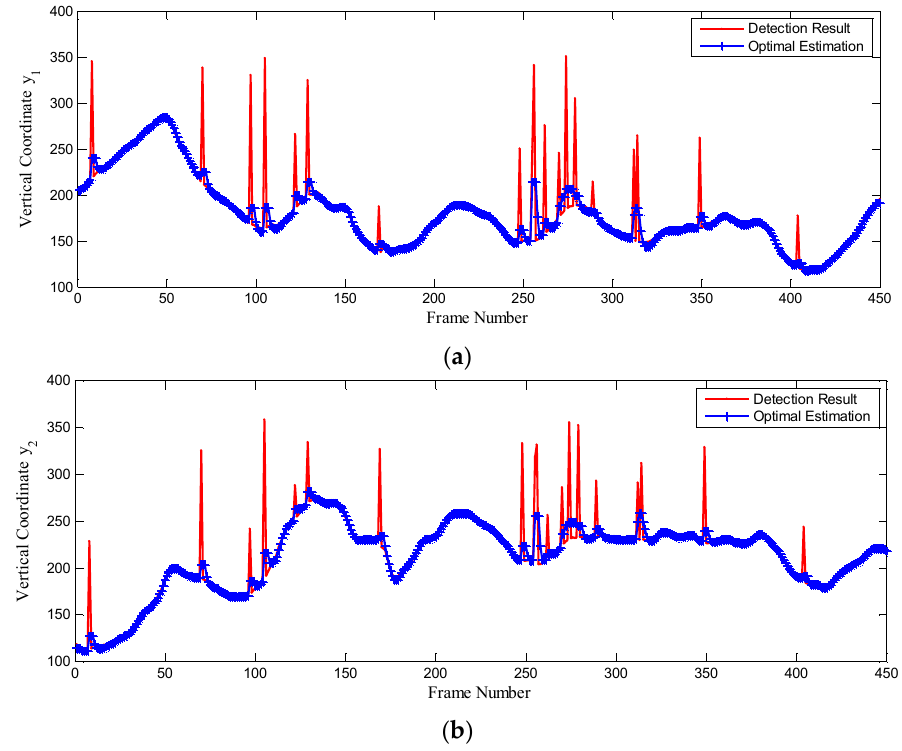
Figure 13. The SSL state comparison of detection results and state estimation by CKF. ( a ) are detection results and state estimation of vertical coordinate y 1 ; ( b ) are detection results and state estimation of vertical coordinate y 2